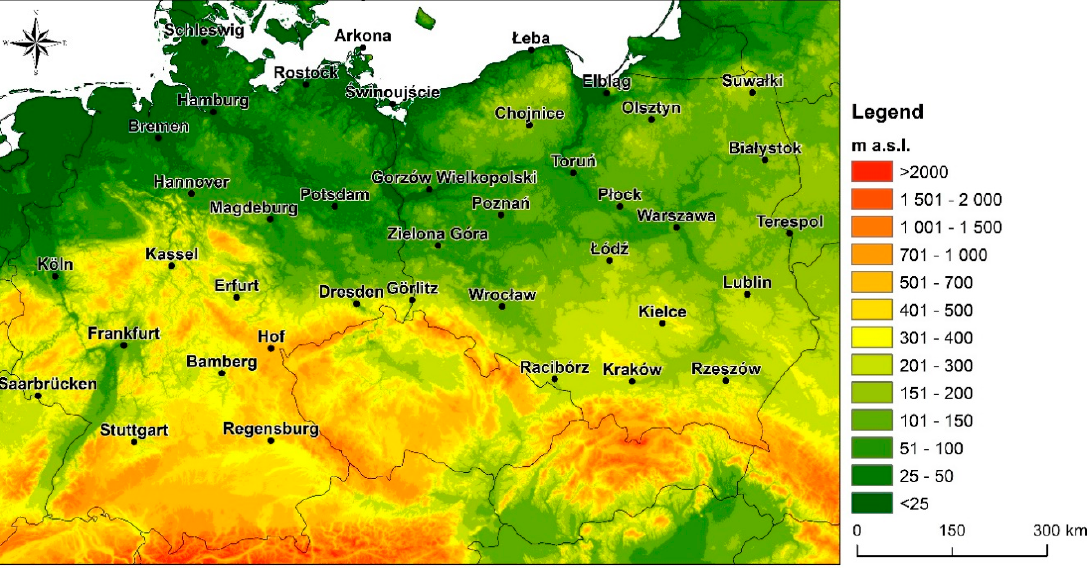
Figure 1. Location of meteorological stations.